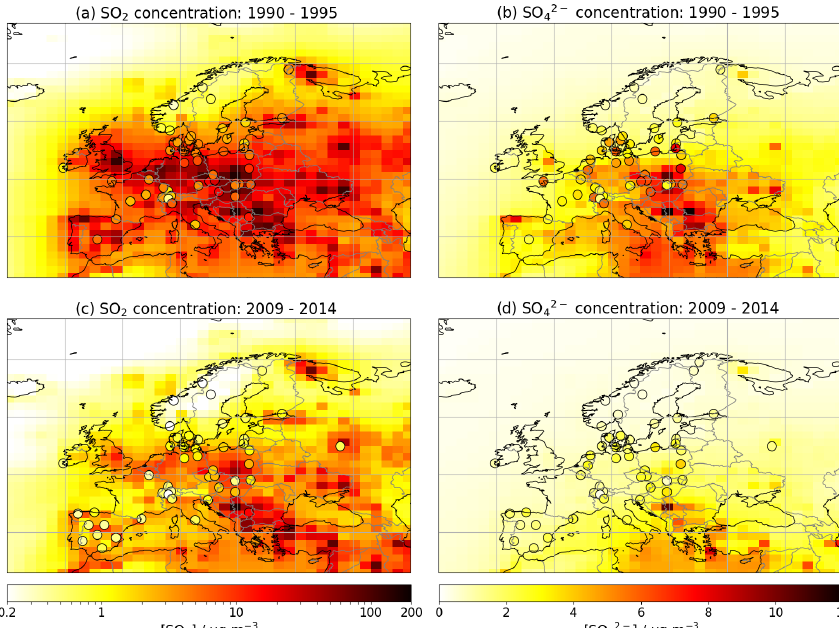
− concentration (b, d) for 1990–1995 (a, b) and 2009–2014 (c, d) 4 ) are plotted as black-edged circles 4